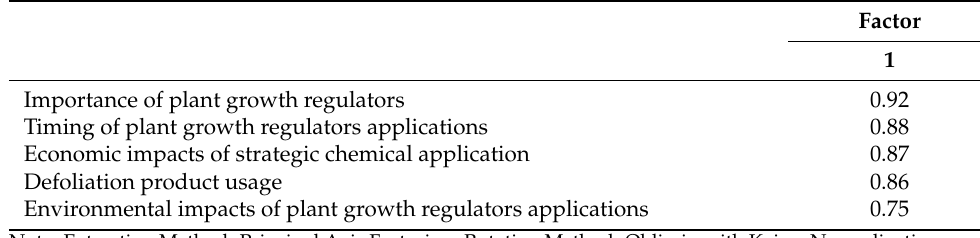
Table 15. Factor loading and proficiency items of other chemical application competencies.